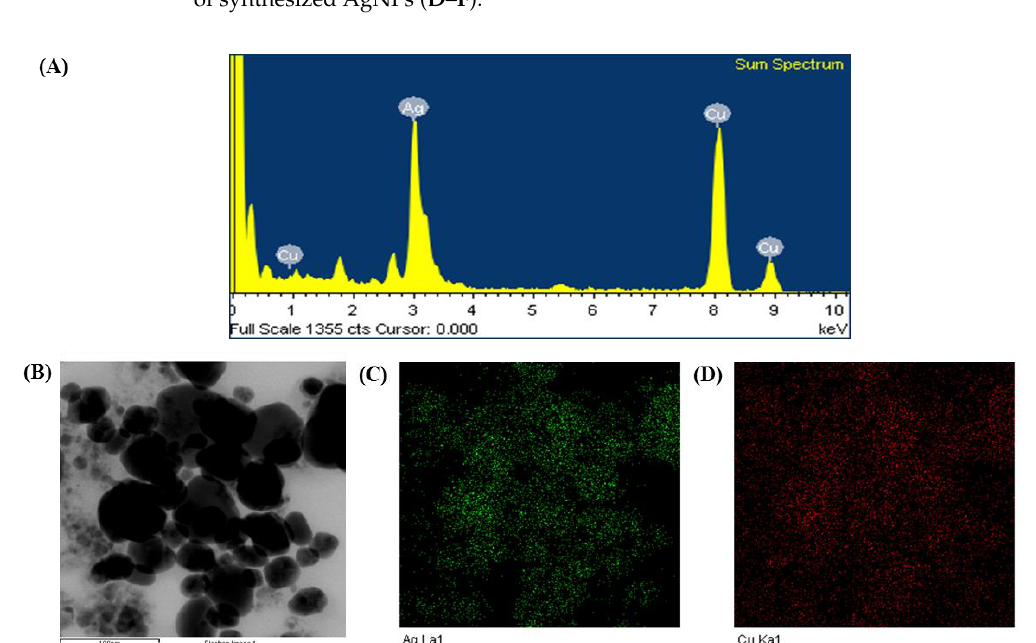
Figure 2. R2A broth as control ( A ), synthesized AgNPs ( B ), UV–Vis spectra ( C ), and FE-TEM images of synthesized AgNPs ( D – F ).